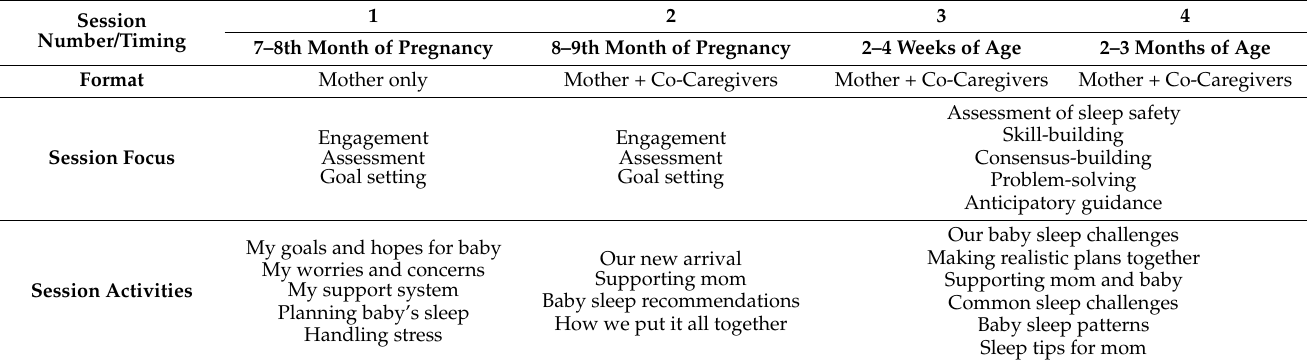
Table 1. My Baby’s Sleep intervention